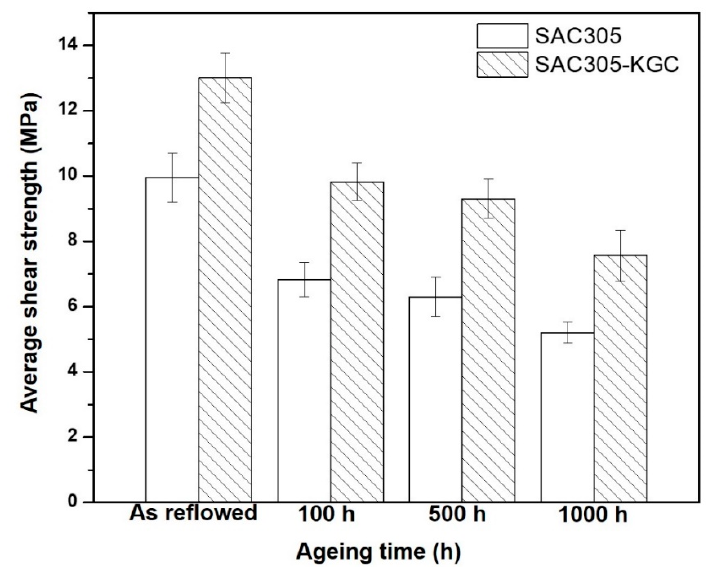
Figure 16. Average shear strength of non-reinforced SAC305 and SAC305-KGC composite prior to reflow soldering and subjected to isothermal ageing at 150 °C.